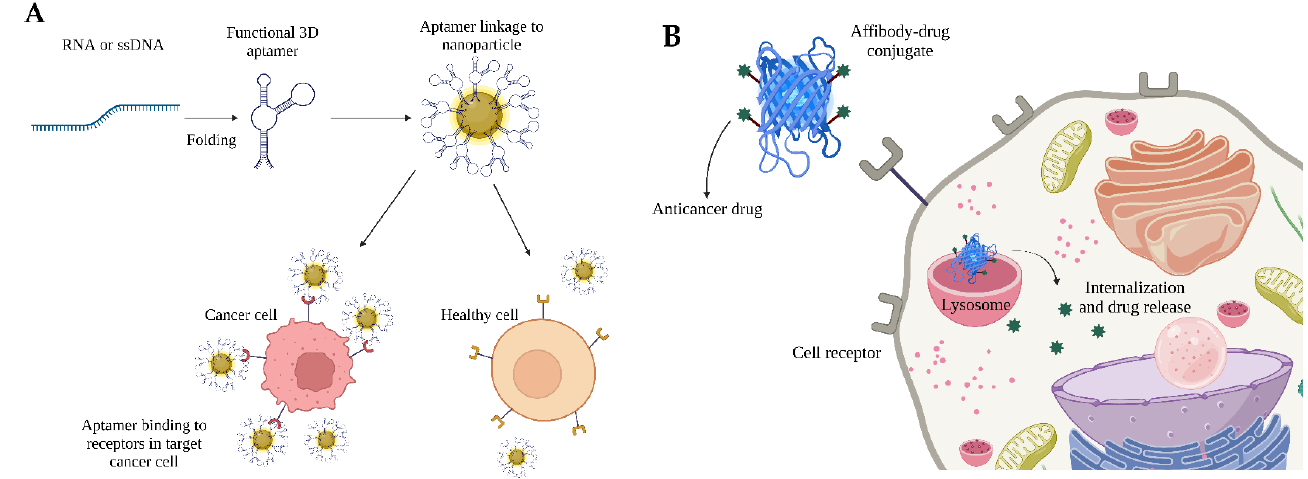
Figure 7. Antibody mimetic molecules are helpful in cancer detection and therapeutics, which can be illustrated as follows: ( A ) Aptamers can be either RNA or ssDNA that can fold itself to form a functional aptamer and can be decorated on the surface of nanoparticles for the specific detection of cancer cells; ( B ) Affibody bound to anticancer drugs can specifically bind cancer cell biomarkers, thus channelizing the drugs inside the cells and aiding drug release leading to cancer cell death.